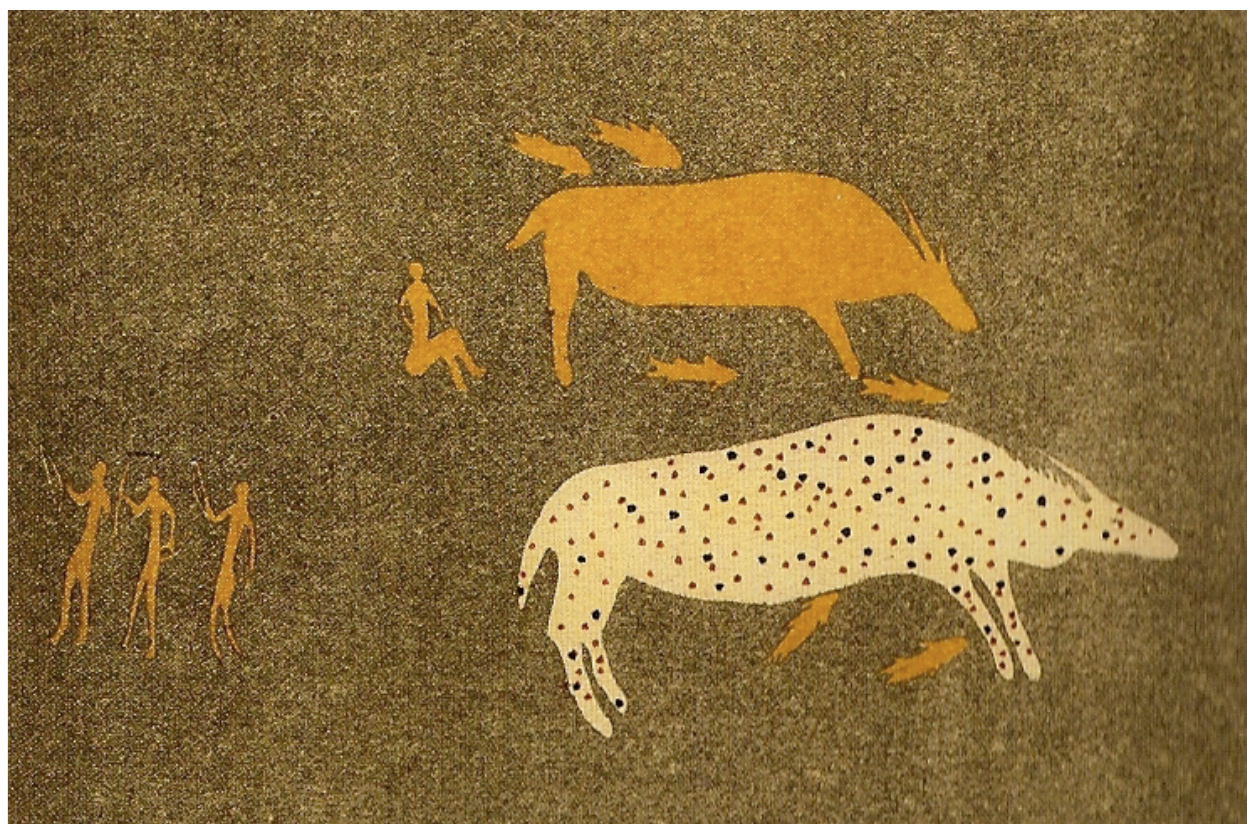
Figure 6. Spotted Elands . Traced by Helen Tongue 1906/7. Willow Grove, Wodehouse. District, South Africa. Published in Bushman Paintings , 1909, Pl. XVIII-29, Reference in Le Quellec, Rock Art in Africa: Mythology and Legend